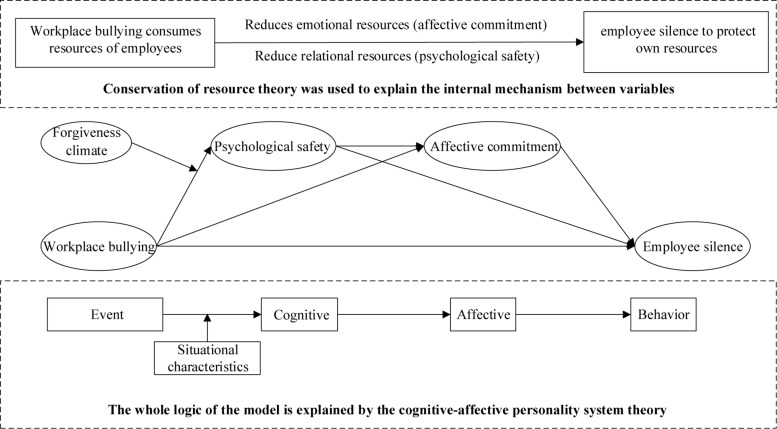
Theoretical model.